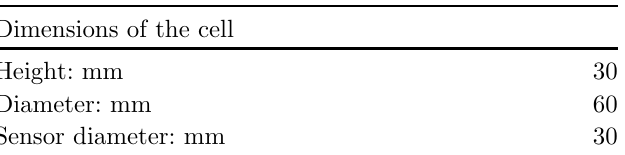
Table 3. Dimensions of the isochoric cell used for swelling pressure